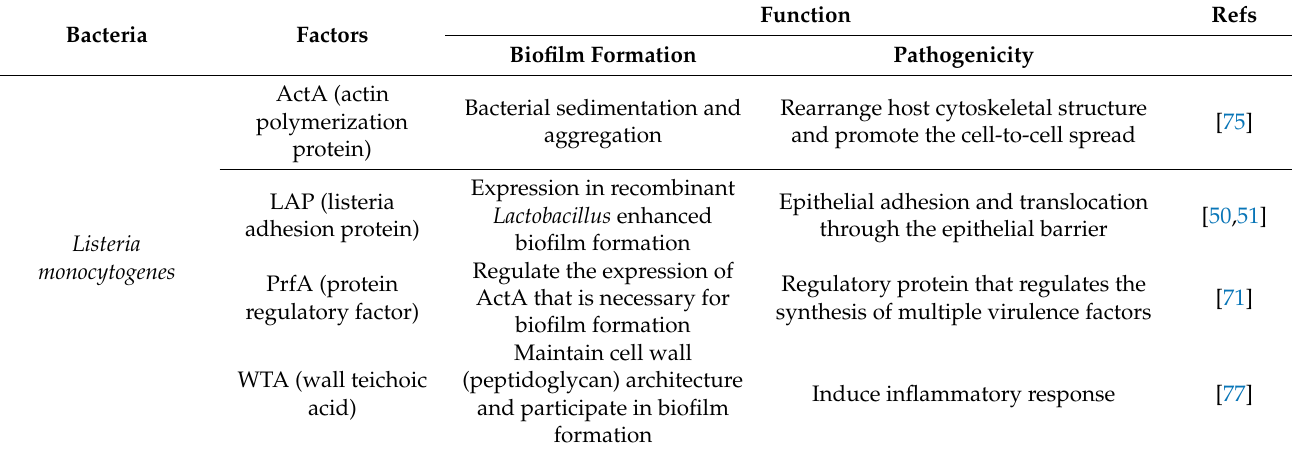
Table 2. Bacterial factors involved in biofilm formation and